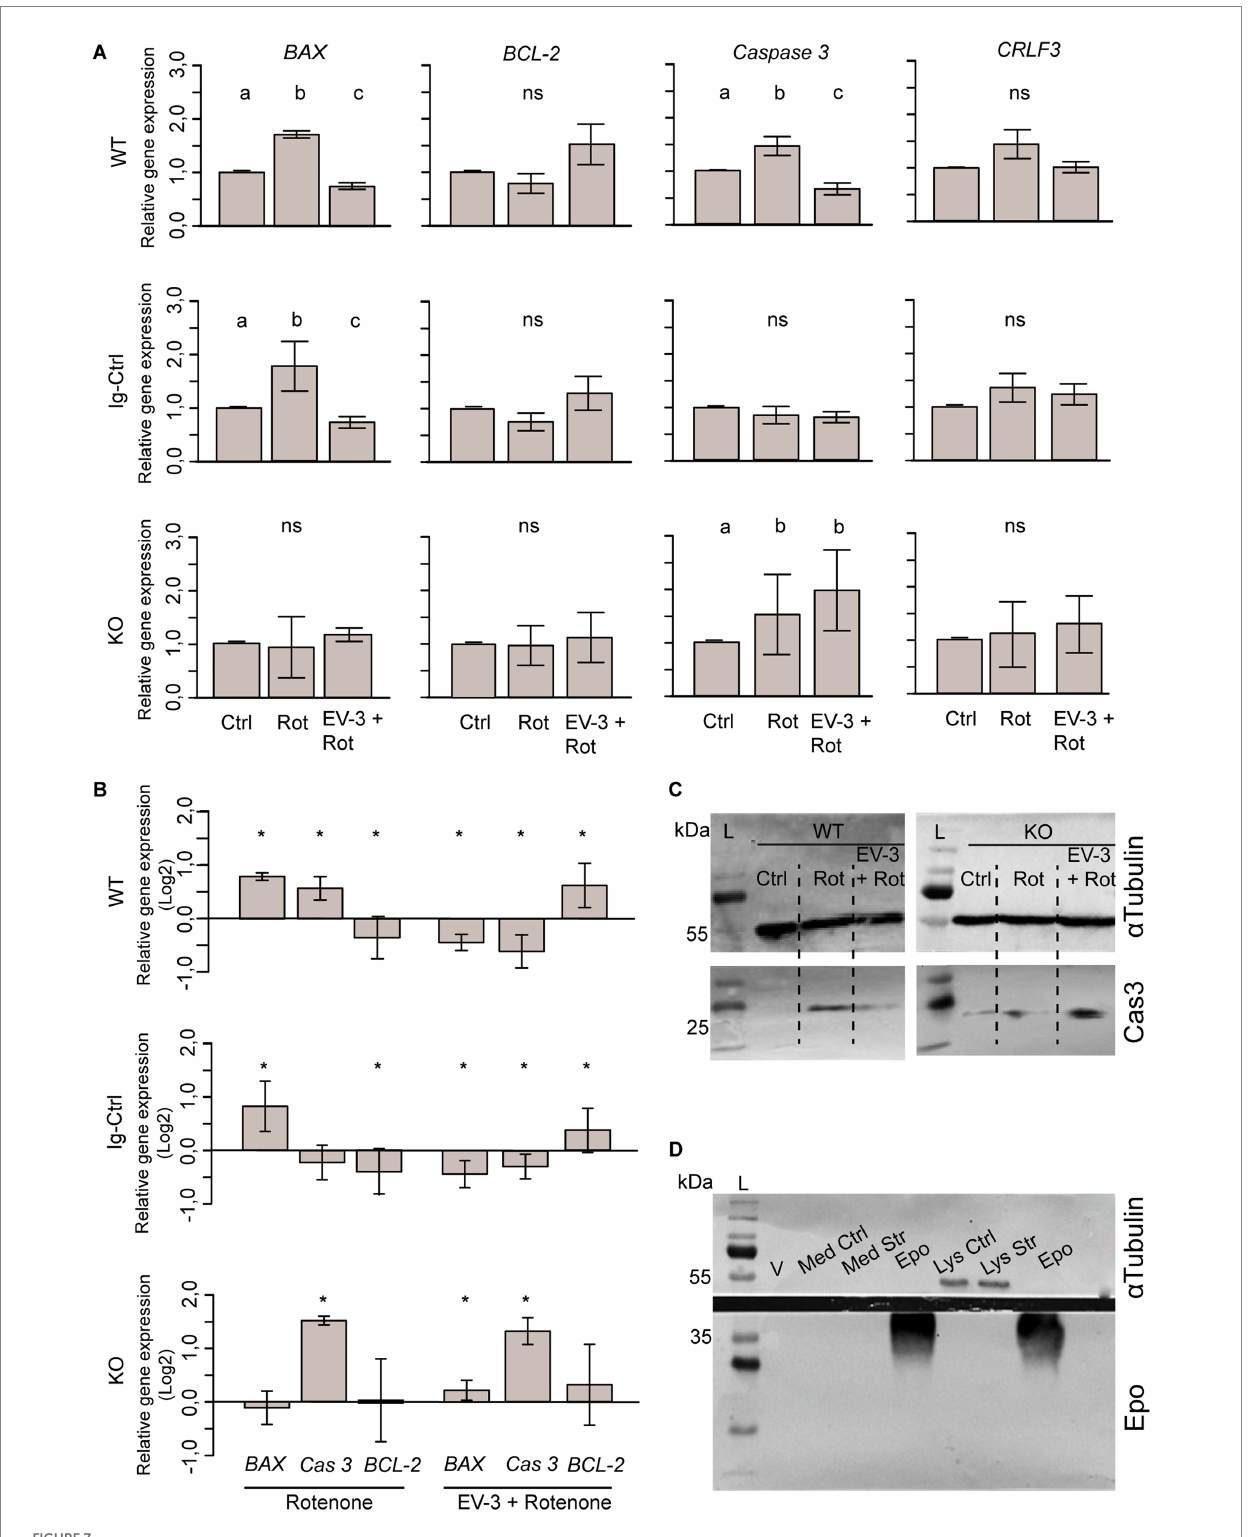
FIGURE 7 Expression of pro-and anti-apoptotic genes and CRLF3 in iPSC#1-derived neurons. (A) qPCR-based relative gene expression of pro-apoptotic BAX and Caspase 3 , anti-apoptotic BCL-2 and CRLF3 in WT, Ig-Ctrl and CRLF3 KO lines after exposure to rotenone ± EV-3 (12 h EV-3 treatment, followed by 18 h rotenone+EV-3 exposure). Values were normalized to untreated controls. n = 4 for each cell line. Graphics show average ± STDV; statistics with pairwise permutation test and Benjamini-Hochberg correction for multiple comparison. Significant differences (p < 0.05) are indicated by differing lettering. (B) Same data as in (A) illustrated as log2 for direct comparison of GOI up-and down regulation between different treatments of WT, Ig-Ctrl and KO neurons. Relative gene expression in pharmacologically treated cultures were only compared to respective untreated controls. Graphics show average ± STDV; Statistics with t -test. Significant differences ( p < 0.05) are indicated by asterisk. (C) Exemplary Western blot analysis of cleaved caspase